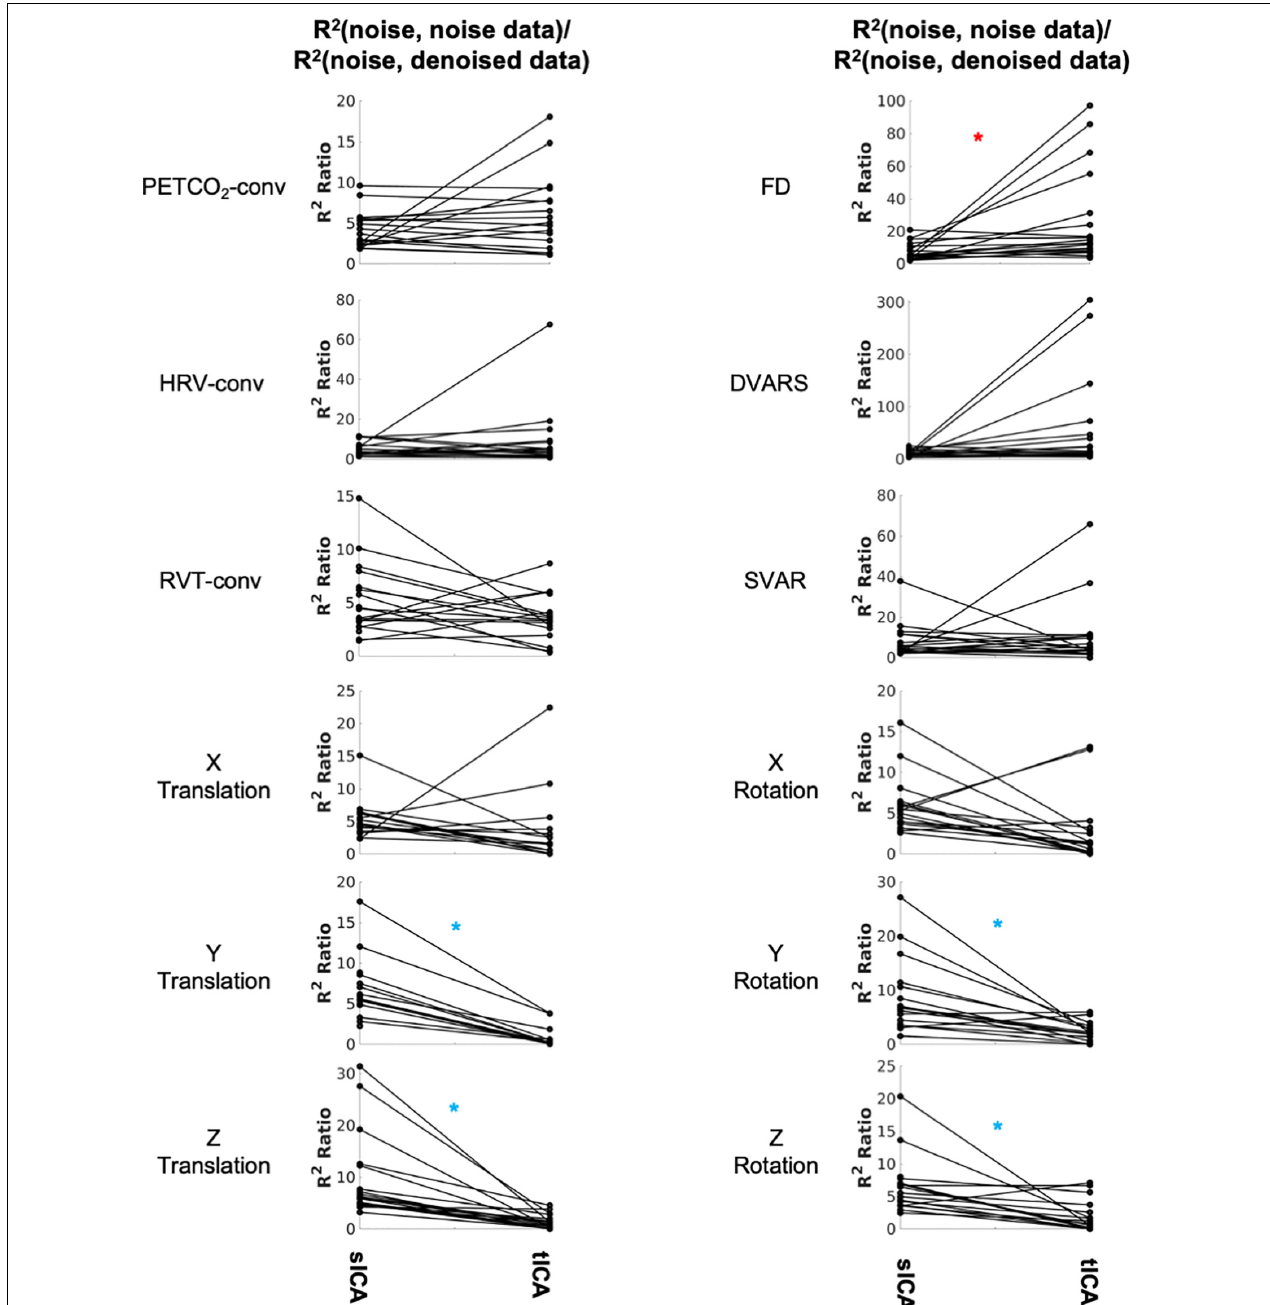
FIGURE 6 | Comparing sICA and tICA in removing the effect of noise: the variance explained by noise type. Each line represents one subject. In each column, each plot shows the ratio of variance accounted for by each noise/artifact source in the noise-related signal identified by sICA and tICA over the corresponding variance in the ICA-denoised signal. A higher R 2 ratio indicates more successful denoising to some extent. Significantly higher values for sICA are indicated by the blue asterisk, whereas significantly higher values for tICA are indicated by the red asterisks. The significance of the changes is indicated in boldface in Supplementary Table 2 .